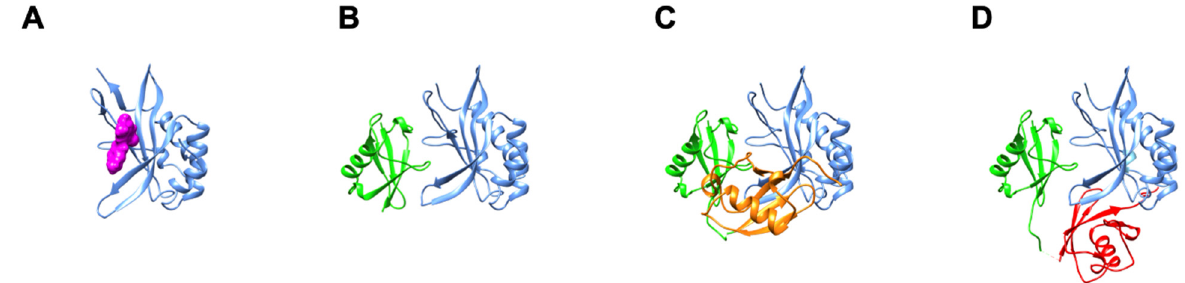
Figure 4. UEV binding modes of tenatoprazole compared to mono- and di-Ub. Panel ( A ), Tsg101 UEV, blue; tenatoprazole, magenta; PDB ID: 5VKG [23]. Panel ( B ), Tsg101 UEV, blue; mono-Ub bound at the β -hairpin, green; PDB ID: 1S1Q [32]. Panel ( C ), Tsg101 UEV, blue; di-Ub distal domain, green, bound at the mono-Ub binding site, di-Ub proximal domain-1, orange, bound at the N-terminal α -helix-1 site; PDB ID: 6UD0 (Strickland et al., submitted). Panel ( D ), Tsg101 UEV, blue; di-Ub distal domain, green, bound at the mono-Ub binding site, di-Ub proximal domain-2, red, bound at the vestigial active site; PDB ID: 6UD0.